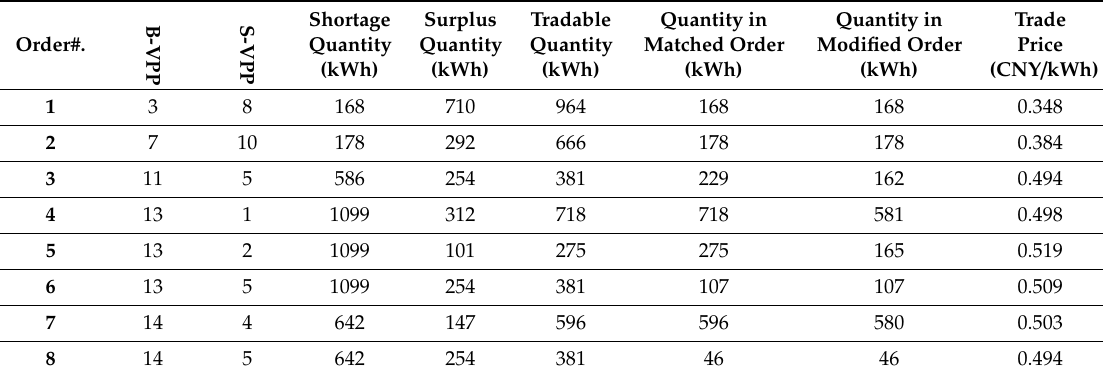
Table 4. Details of the matched orders in t = 3 and R =